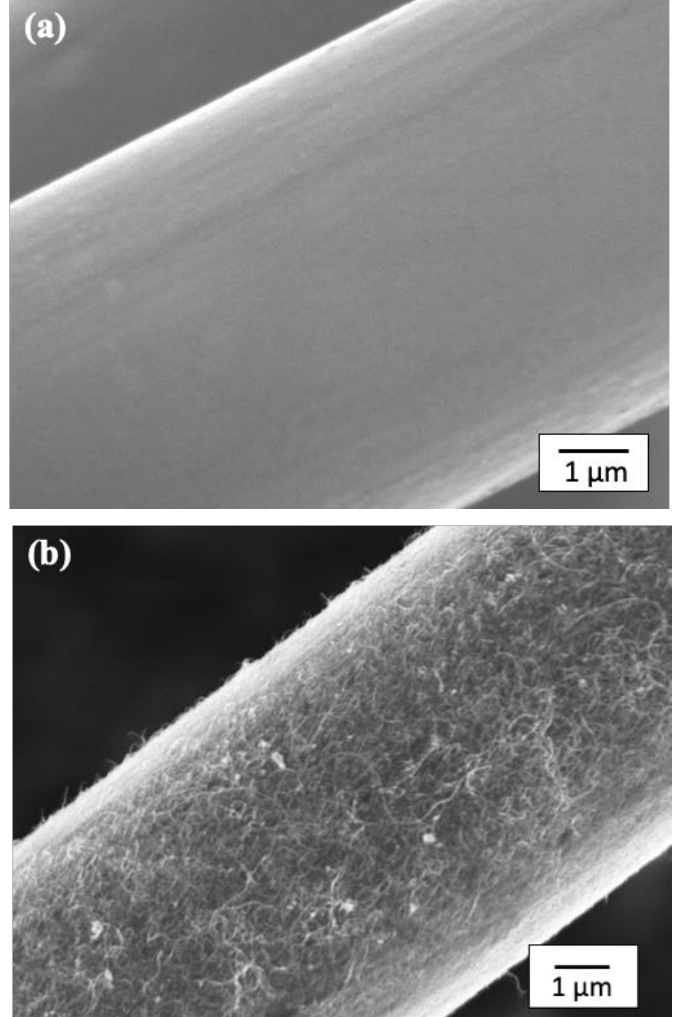
Figure 6. SEM images of the CF surface using the layer-by-layer method. ( a ) CF surface coated with Pipozo (after the first layer, the Pipozo layer was too thin and smooth to be visible by SEM). ( b ) CF surface coated with MWCNTs (after the second layer, and solvent washing several times).